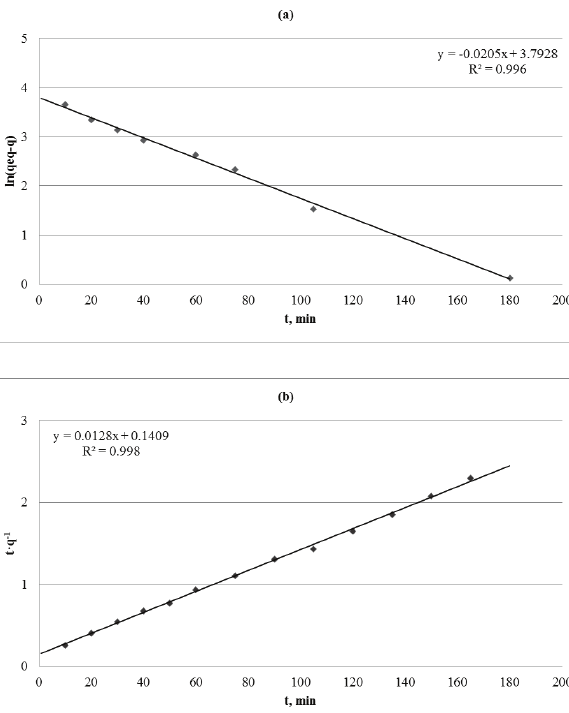
Figure 1. The linearization of pseudo-first (a) and pseudo-second (b) order models for the biosorption of Cr(III) ions by C. glomerata (pH 5, C 0 =300 mg·L -1 , C S =1.0 g·L -1 )